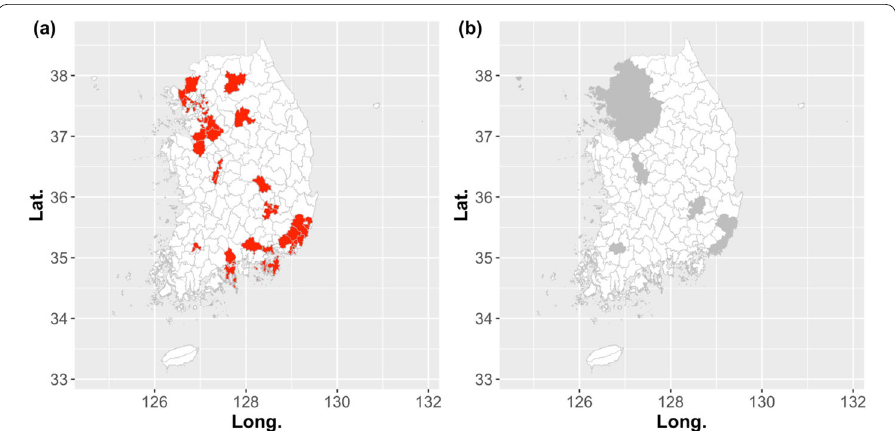
Figure 9 The regions that start earlier than other regions. The city-county-districts where the outbreak start week is earlier than or equals to M s for all seven influenza seasons are marked as red in Fig. 9( a ). Here, M s is the median of outbreak start weeks. In Fig. 9( b ), we show the metro and rural areas depicted in gray and white, respectively, for comparison